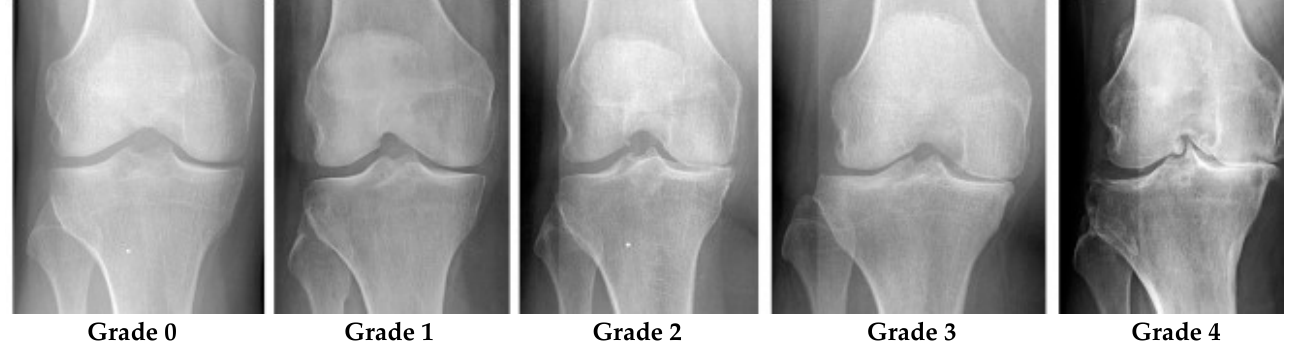
Figure 2. Knee joint samples of all KL grades [2].